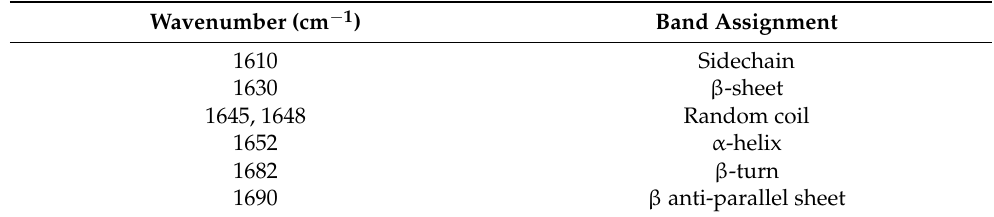
Table 3. Assignment of protein secondary structure based on the IR amide I band